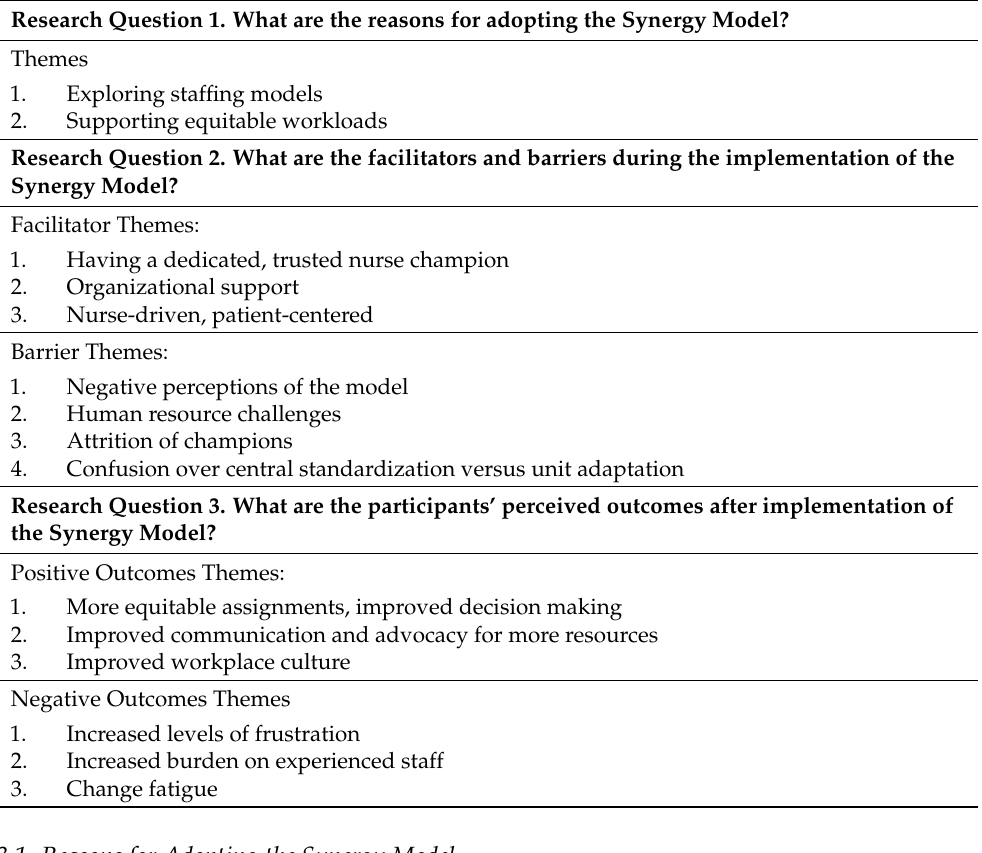
Table 1. Summary of themes by research